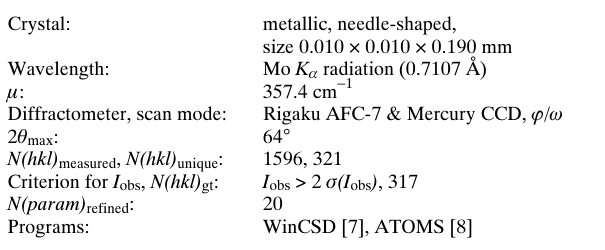
Table 1. Data collection and